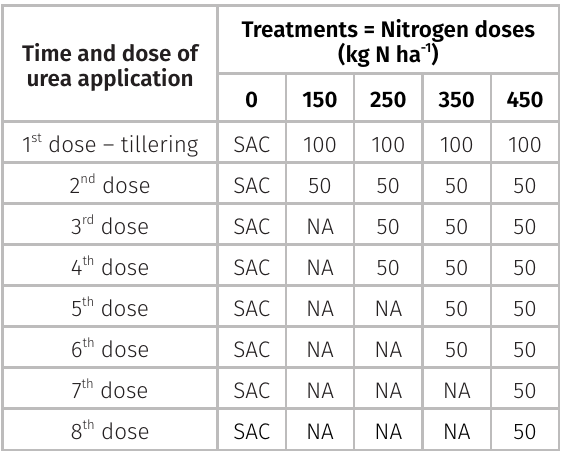
Table II. Treatments used during the cultivation of dual-purpose wheat BRS Tarumã.